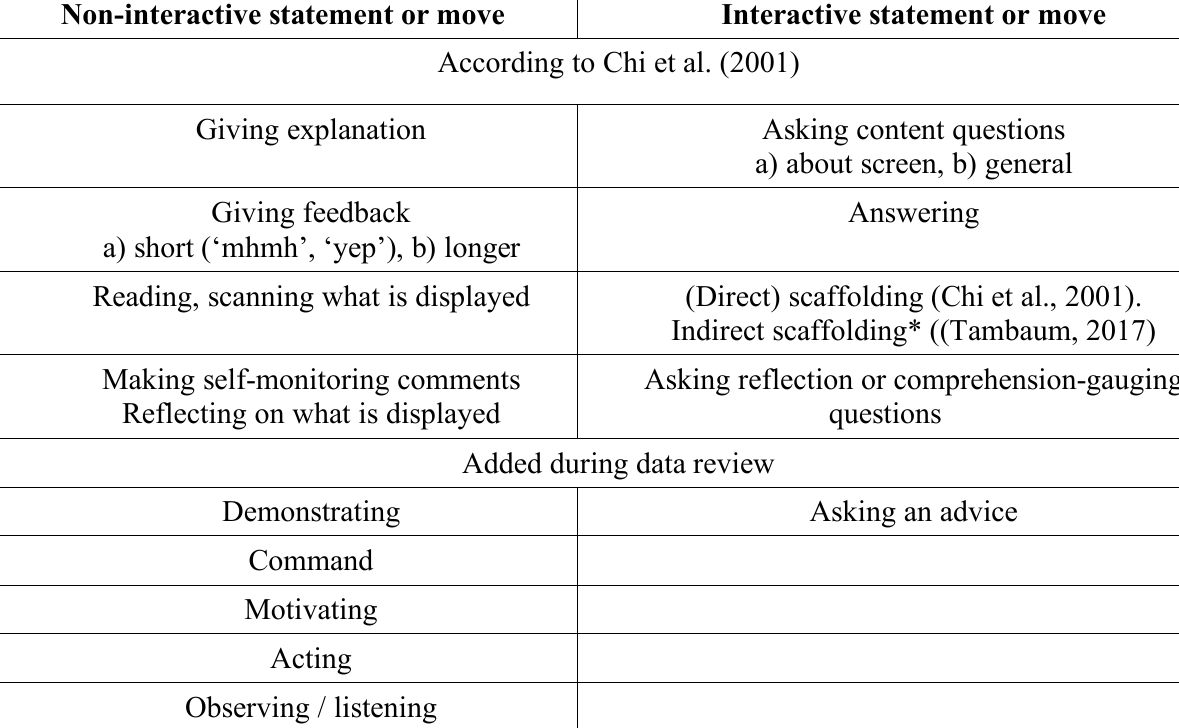
Table 2. Categories of tutoring techniques used in the study Non-interactive statement or